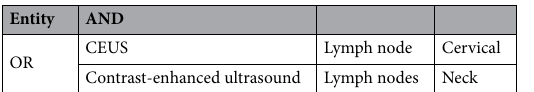
Table 1. Scheme presenting the search request of the systematic